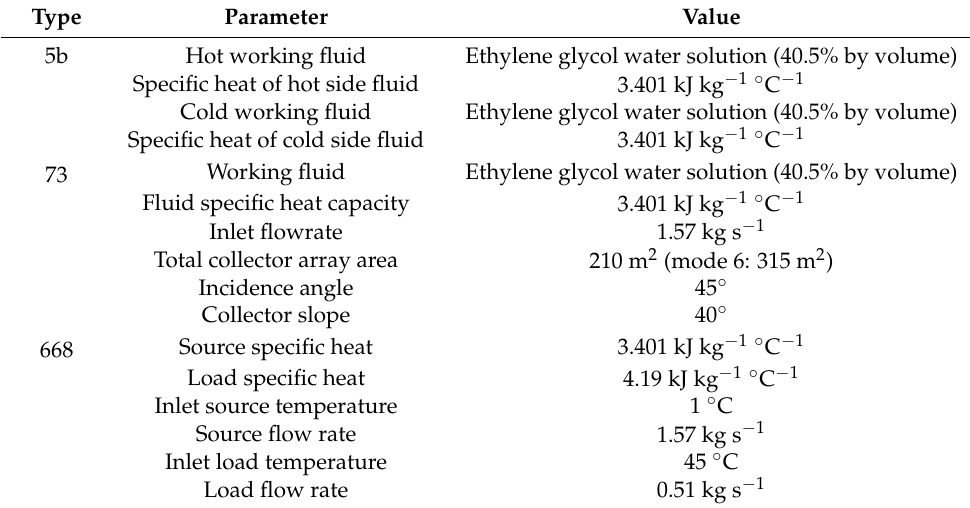
Table 2. Parameters of the main